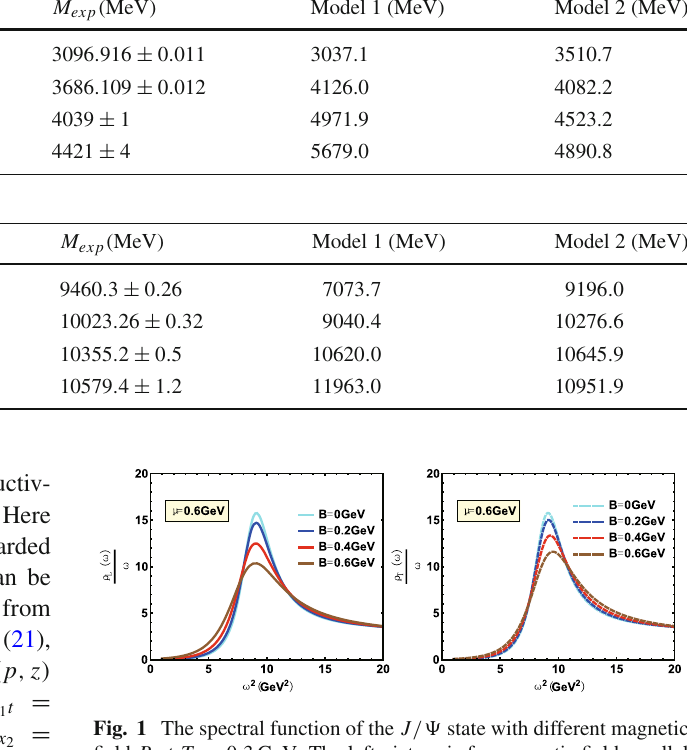
for the Charmonium S-wave resonances. Experimental results are from PDG [67]